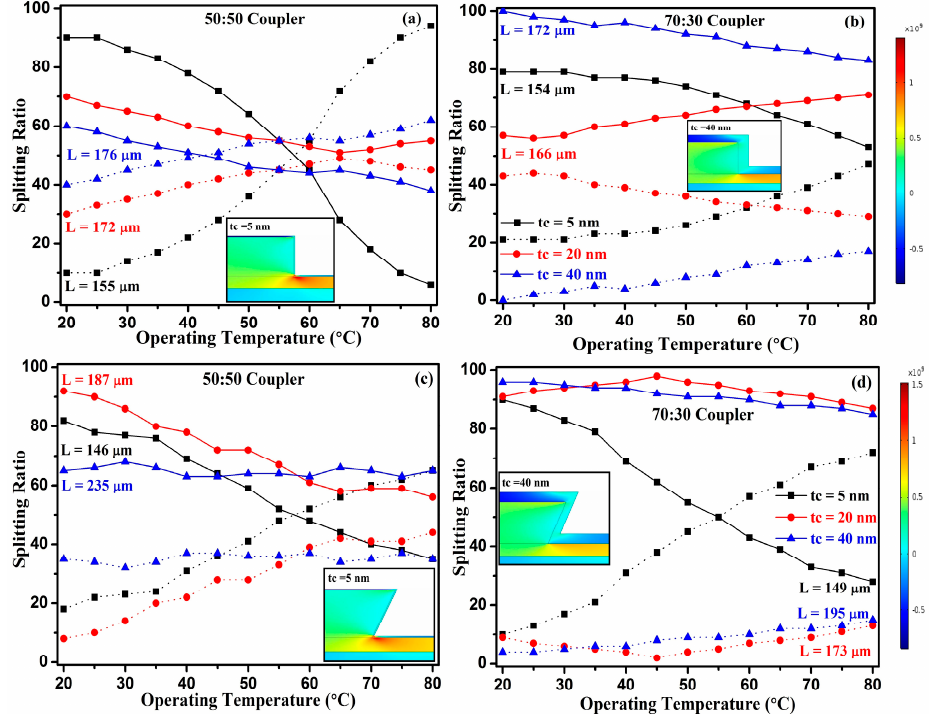
Figure 3. Variation in power splitting ratio ( a ) 50:50, ( b ) 70:30 for rectangular ( θ = 90 ◦ ) and ( c ) 50:50, ( d ) 70:30 for trapezoidal ( θ = 110 ◦ ) ridge waveguides as a function of operating temperature in the presence of stress. L is the coupling length at which the specific splitting ratio can be attained for particular SiGe cladding thickness. The solid and dashed lines show power splitting ratios at bar port and cross port, respectively.